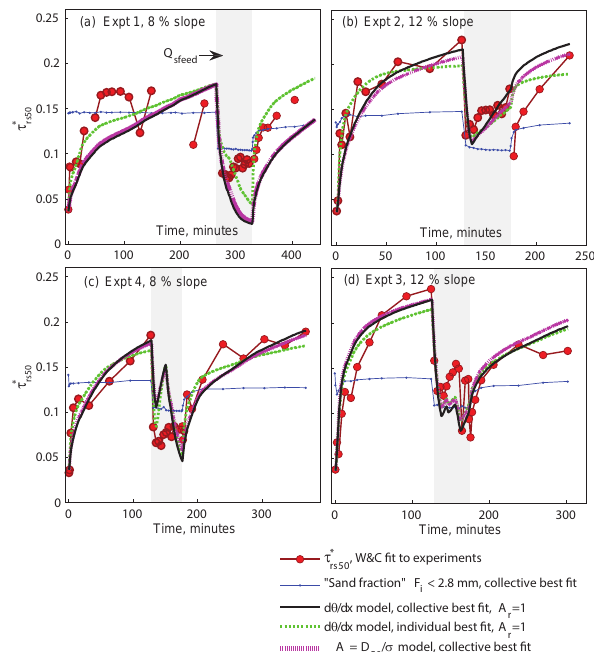
Figure 5. Best-fit models (Eqs. 4, 8 and 10) compared to ex- perimental constraints. The periods of upstream sediment supply ( Q sfeed ) are indicated by the grey boxes for each